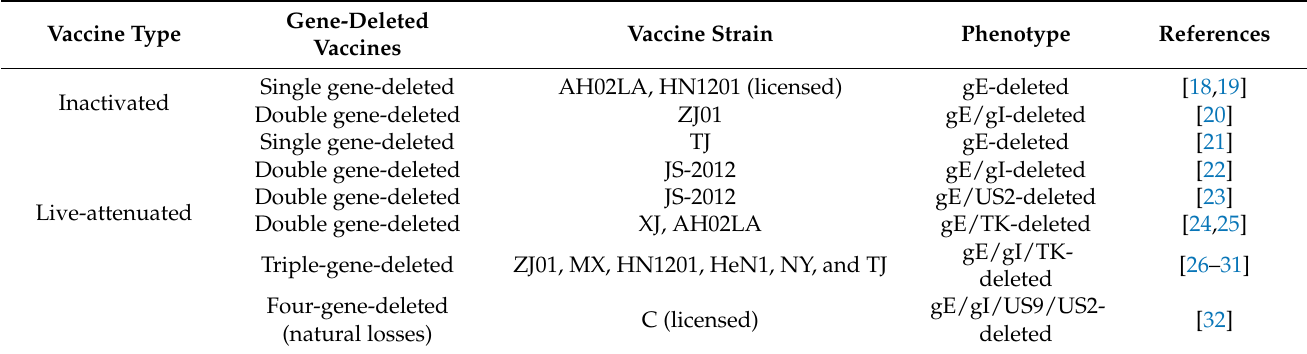
Table 1. List of genetically modified vaccines based on emerging PRV in